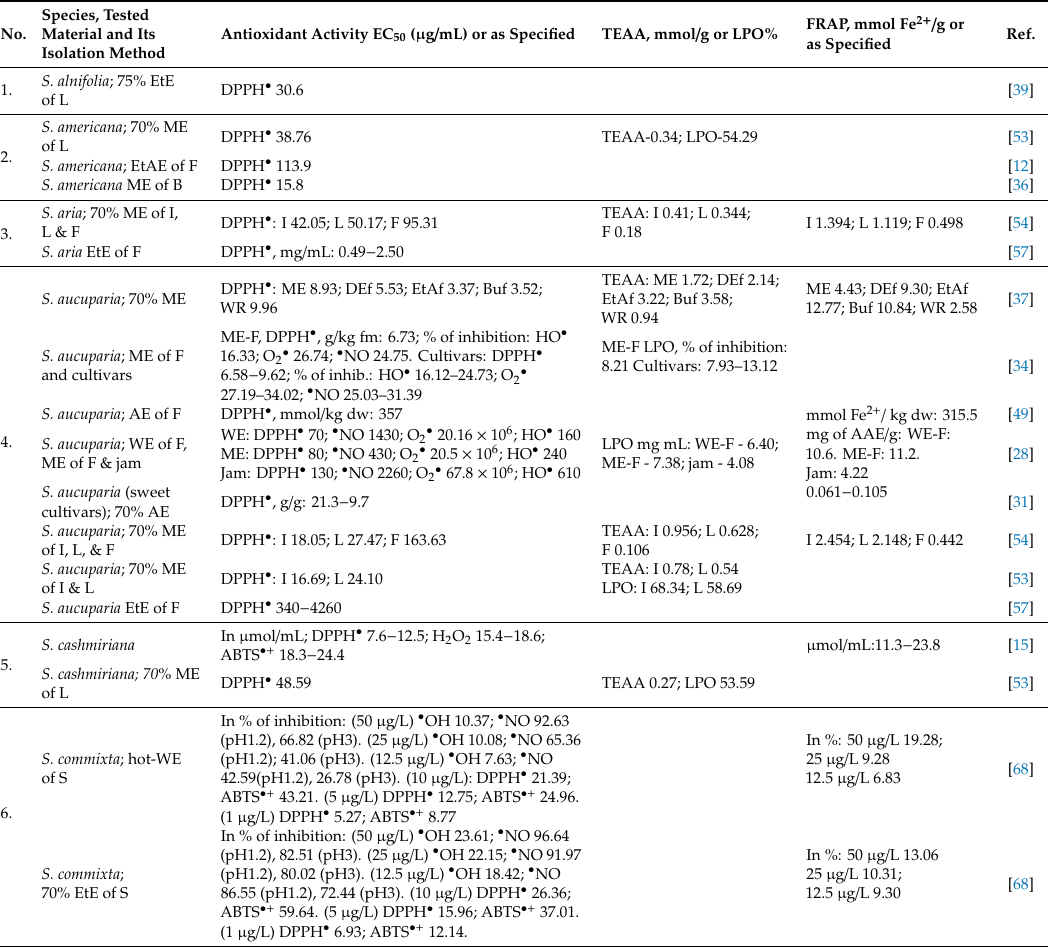
Table 3. Bioactivity of selected Sorbus